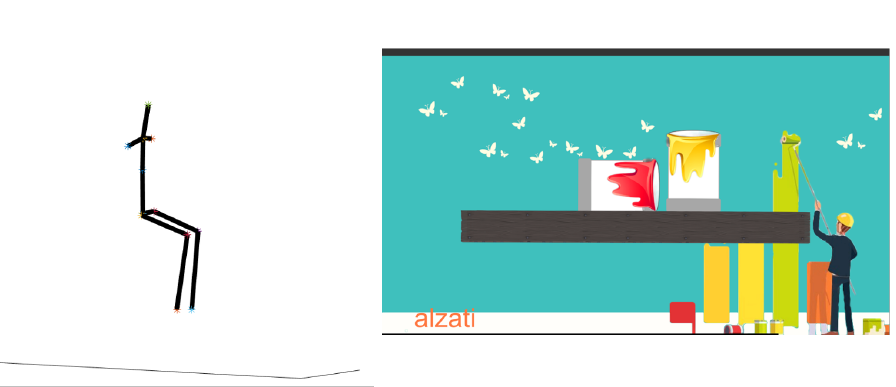
Figure 6. ( left ) Still reconstruction of movement for joints involved in indicator calculations (joints 1, 3–5, and 17–23 in Figure 2). Whole movement visible in the attached Video S1. ( right ) Screenshot of Equilibrium